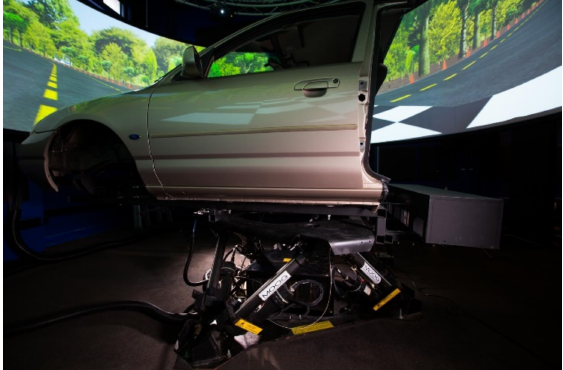
Figure 4. Simulator (motion